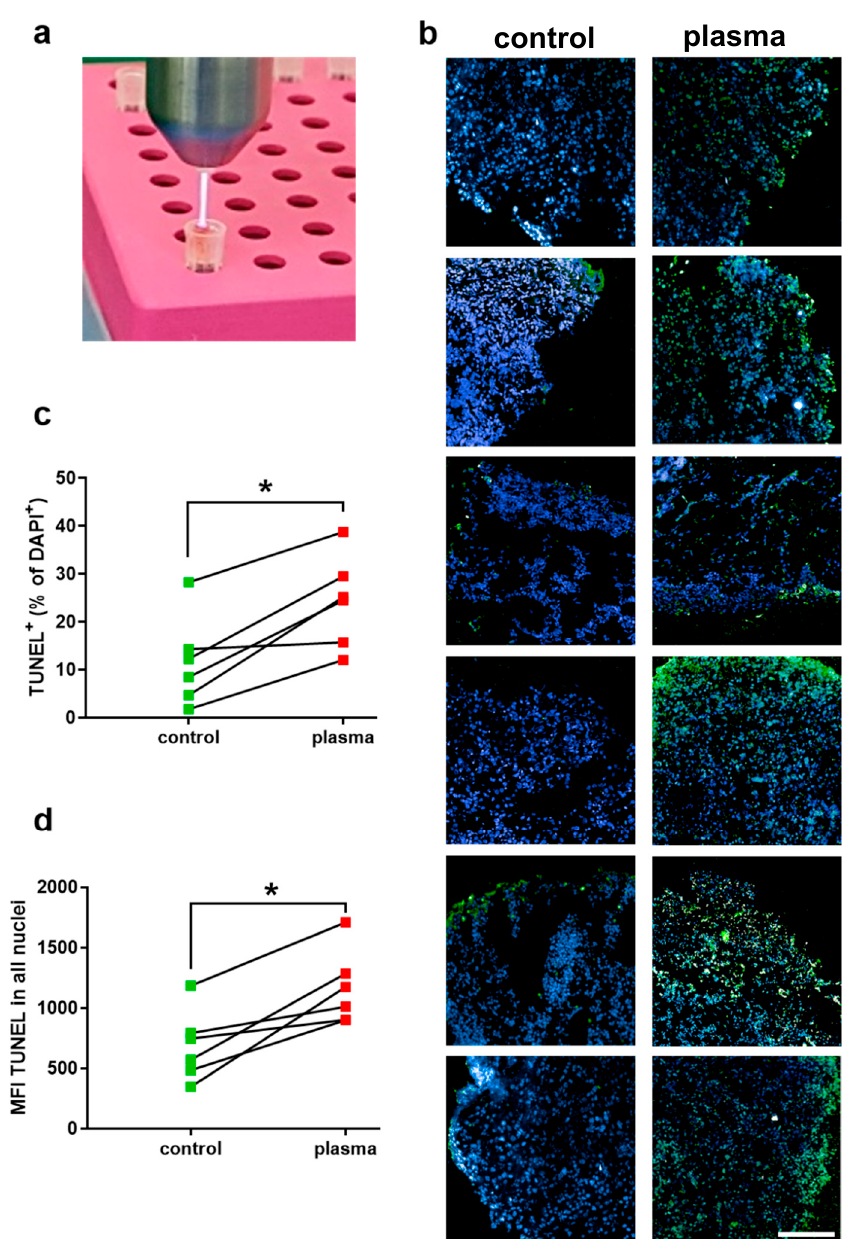
Figure 1. ( a ) Cold physical plasma treatment of cutaneous melanoma tissue was performed ex vivo with an atmospheric pressure argon plasma jet (kINPen MED); ( b ) nuclei (blue) and apoptotic cells (green) in control and plasma-treated tissue sections at 24 h; ( c , d ) percentage of apoptotic cells ( c ) and mean fluorescence intensity (MFI) of TUNEL in all nuclei ( d ) as calculated using nuclei segmentation and quantitative image analysis of several sections of control and plasma-treated tissue. Data are mean of results from 6 patients; asterisks indicate a significant difference ( p < 0.05) between groups as identified with Wilcoxon matched-pairs rank test. Scale bar is 200 µm.